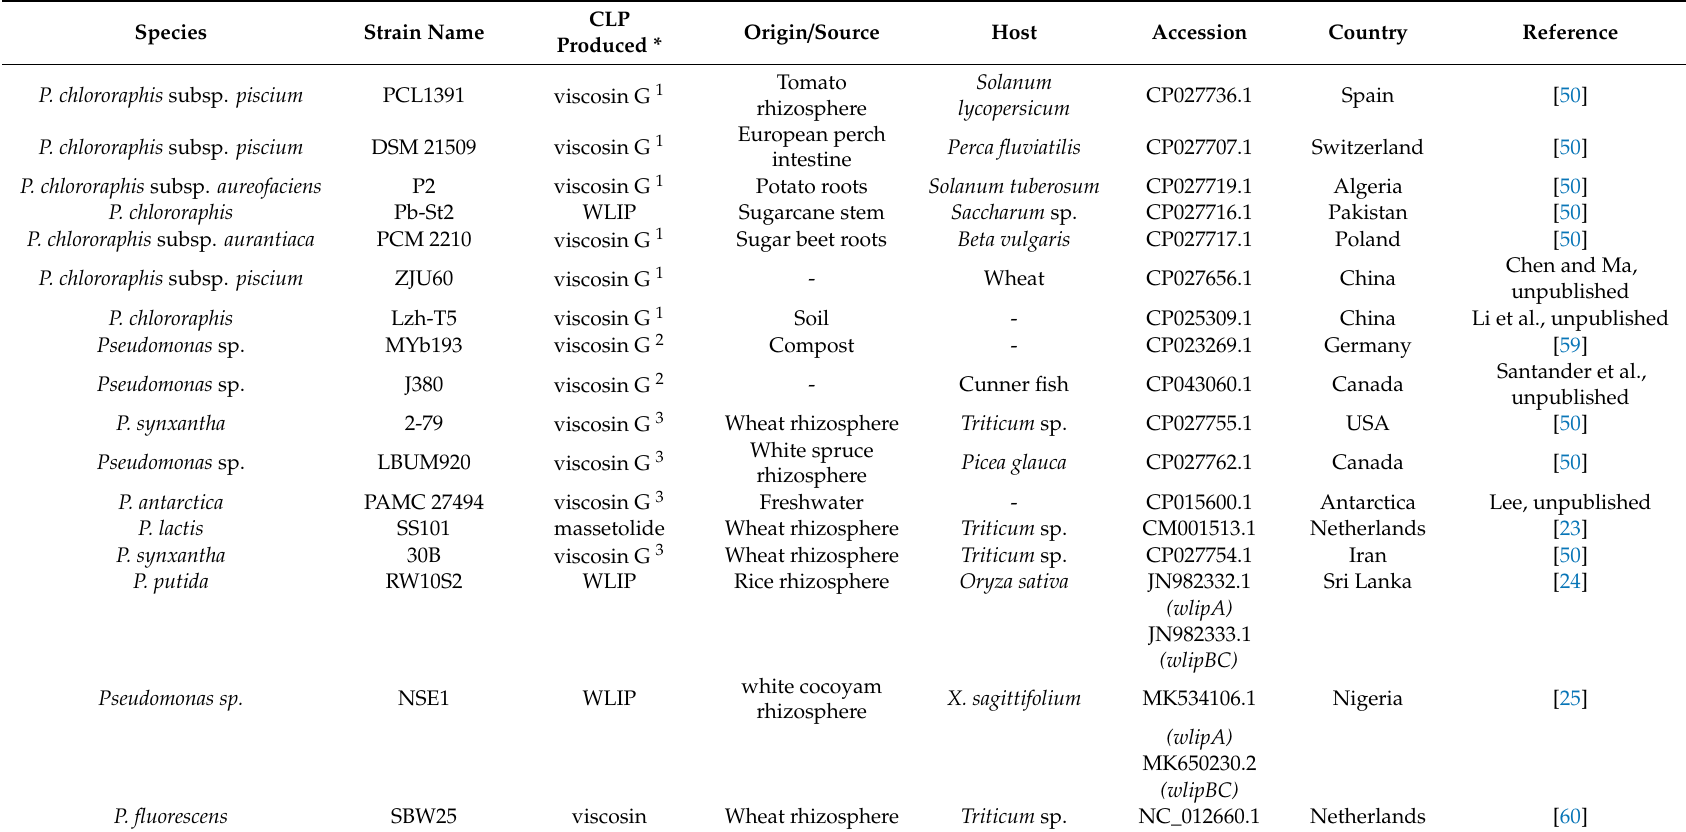
Table A1. List of strains and genomes used during this study and their relevant